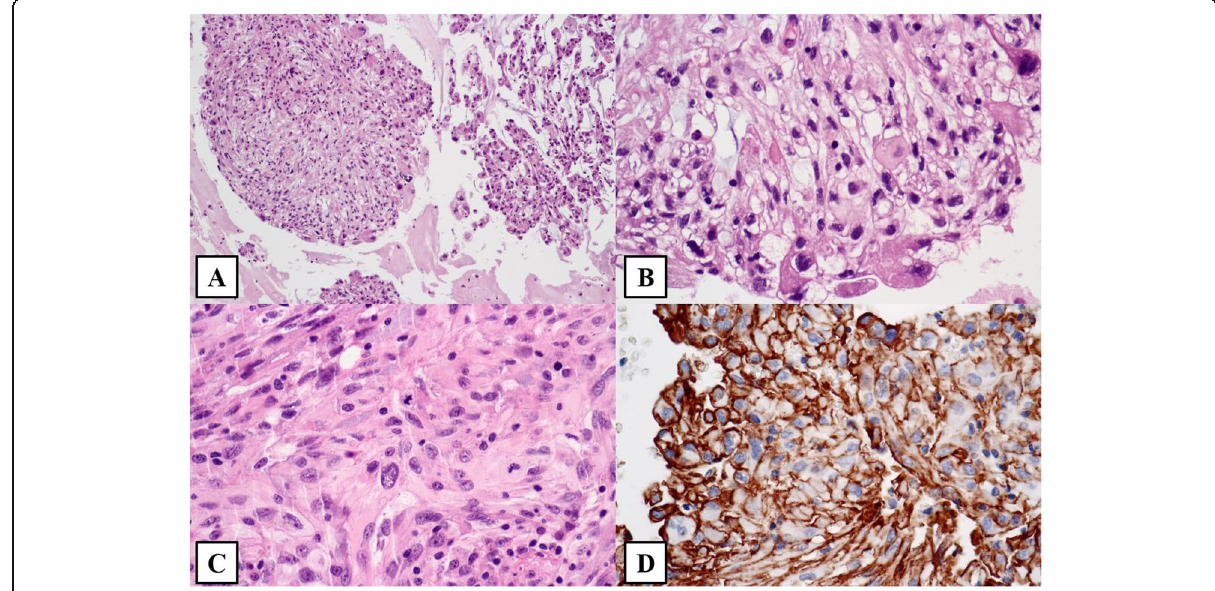
Fig. 2 A metastatic carcinoma in the brain of a 68-year old female patient with a not biopsied kidney mass. It has minute areas of cytoplasmatic clearing ( a and b HE stain at 100x and 400x magnification). Most of the tumor showed, however, sarcomatoid morphology ( c HE stain, 100x). Pan-cytokeratin and PAX8 were diffusely positive. When a kidney primary is considered, the expression of carbonic anhydrase IX in membranous and diffuse pattern is specific for clear cell subtype ( d